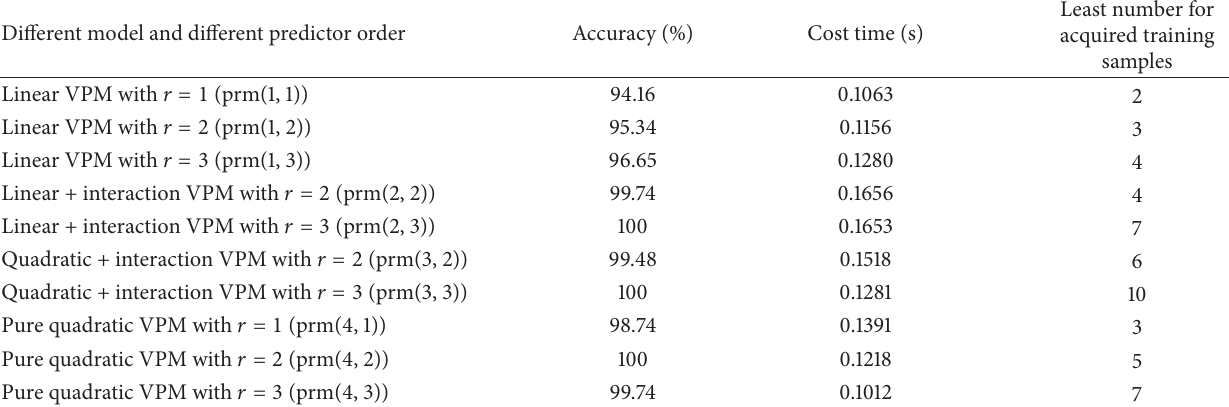
Table 5: The test results of different classifier based VPMCD methods.